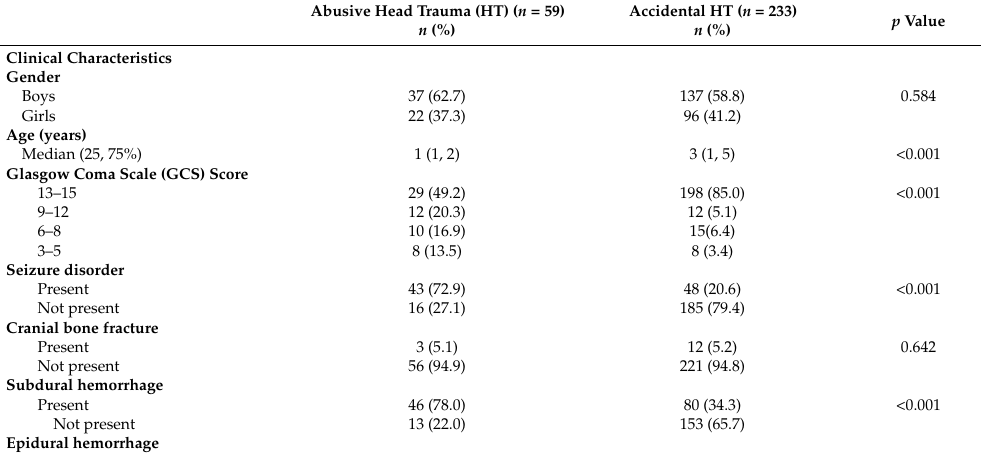
Table 1. Demographic and clinical characteristics of all children with abusive and accidental head